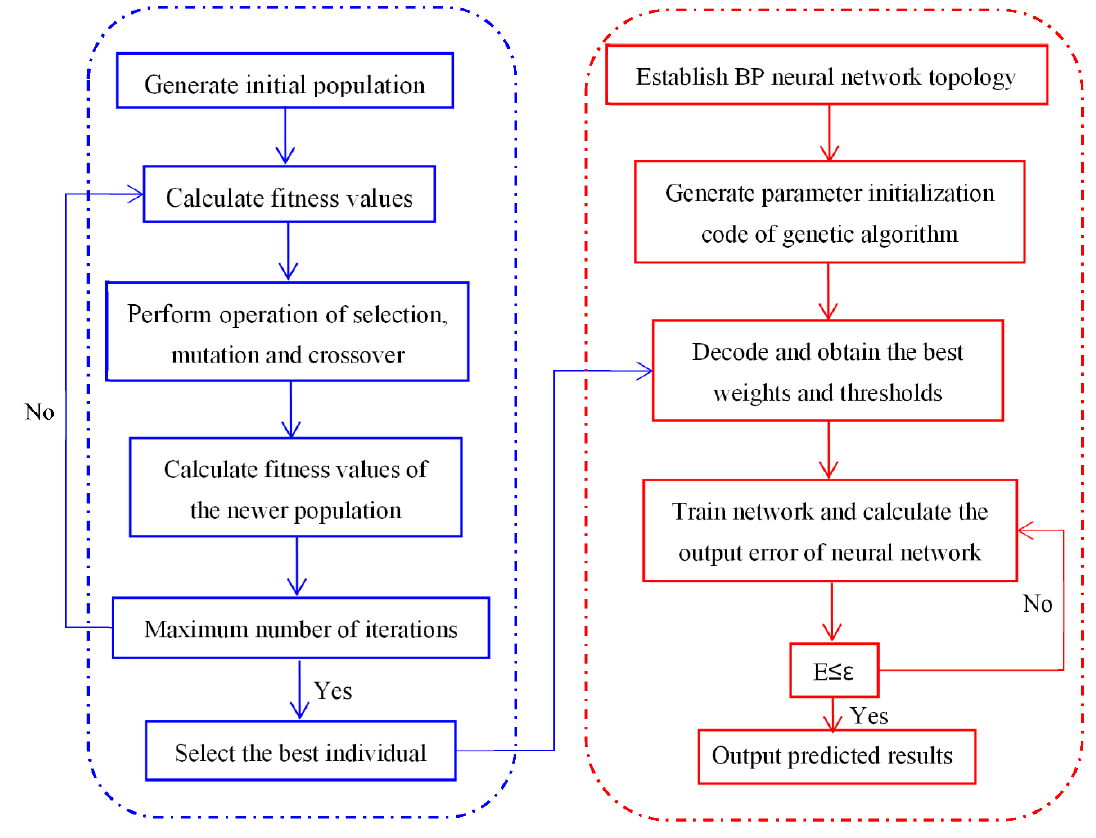
Figure 2. Workflow of the proposed genetic algorithm optimized BP neural network models.